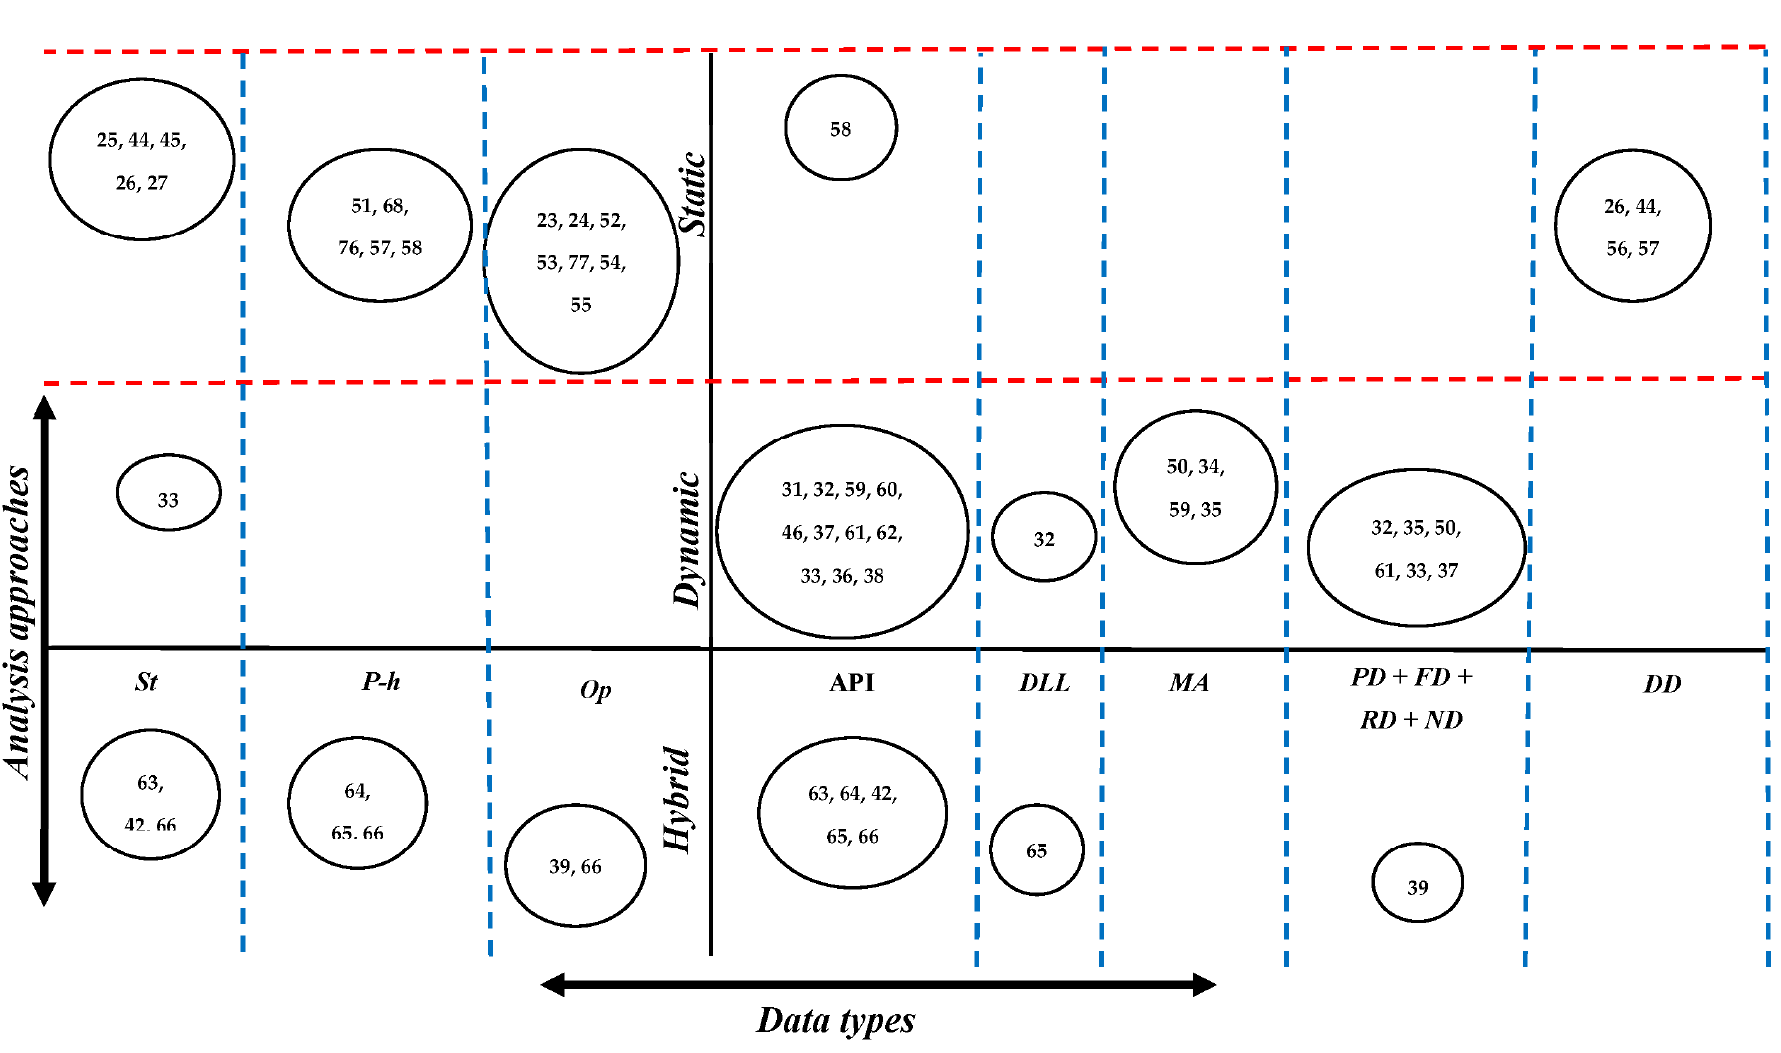
Figure 4. Analysis approaches vs. data types .